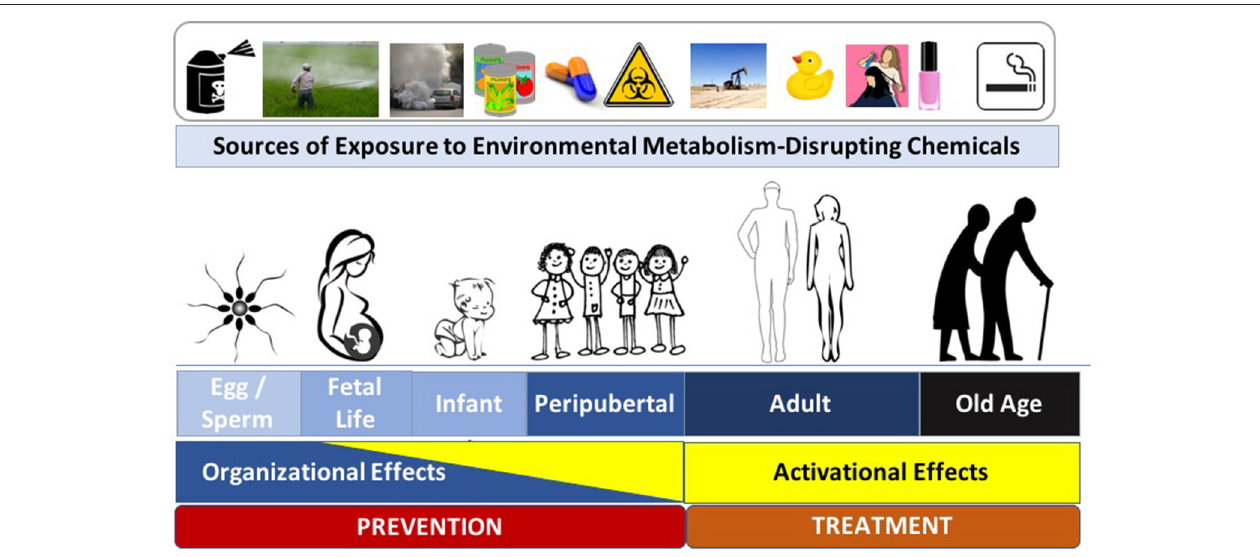
FIGURE 1 | Metabolism-Disrupting Chemicals (MDCs) across the Lifespan. Exposure to MDCs can exert adverse effects across the lifespan. Later in life the effects of MDCs are principally activational; however, early in life, MDCs can exert organizational effects that program increased long-term risk to metabolic diseases. Interventions to prevent adverse metabolic effects from environmental toxicants include efforts aimed at disease prevention (to principally address potential organizational effects) and disease treatment (to principally address activational effects). Images from pixabay.com and